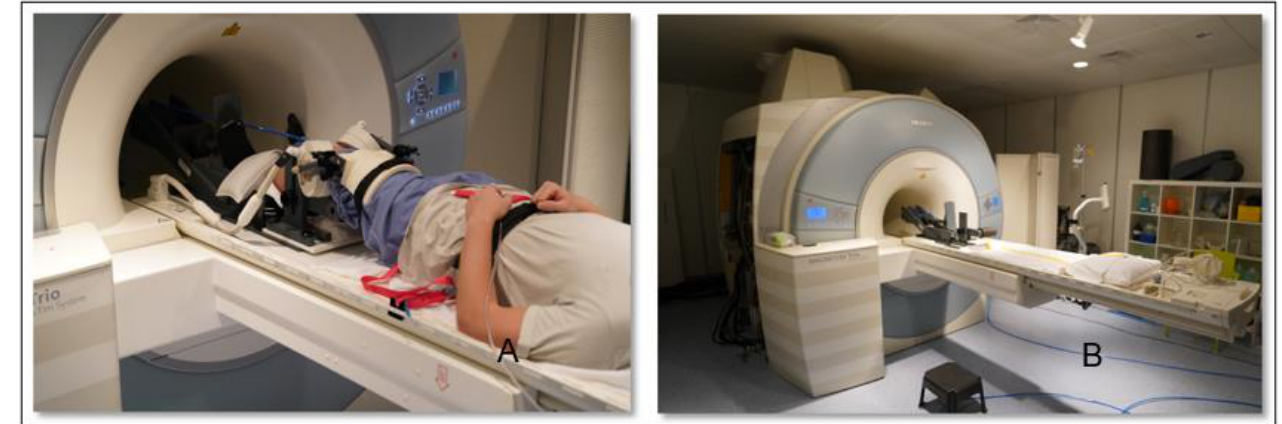
Table 1. Overview of the patients’ and volunteers’ demographics.